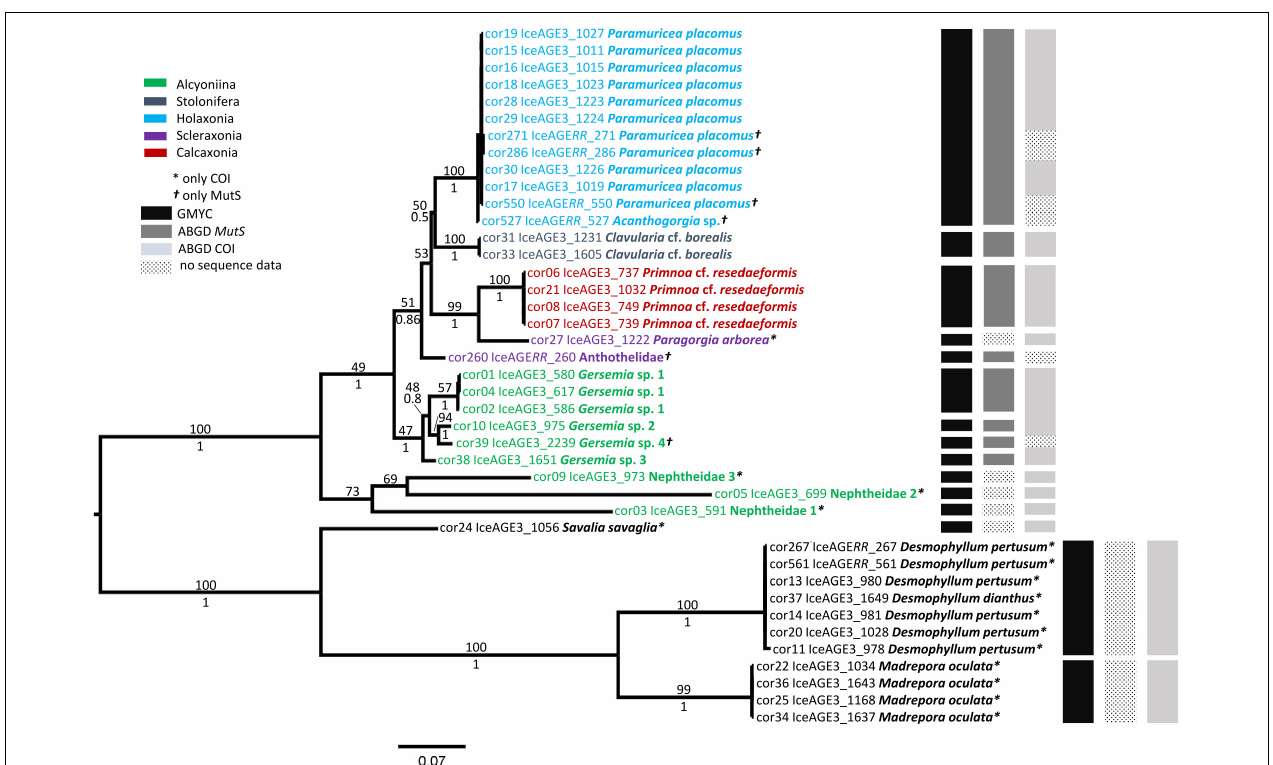
FIGURE 2 | The phylogenetic tree of the Octocorallia and the Scleractinia based on the Maximum Likelihood (ML) analysis of concatenated sequence data from 41 specimens for the mitochondrial gene mtMutS and COI. Bootstrap percentages of the ML analysis are given above the branches. Bayesian posterior probabilities are located below the branches. The black and gray bars on the right show the results of the GMYC and ABGD species discrimination methods, respectively. The GMYC model was achieved with the concatenated sequence data. ABGD method was performed with single alignment data for each